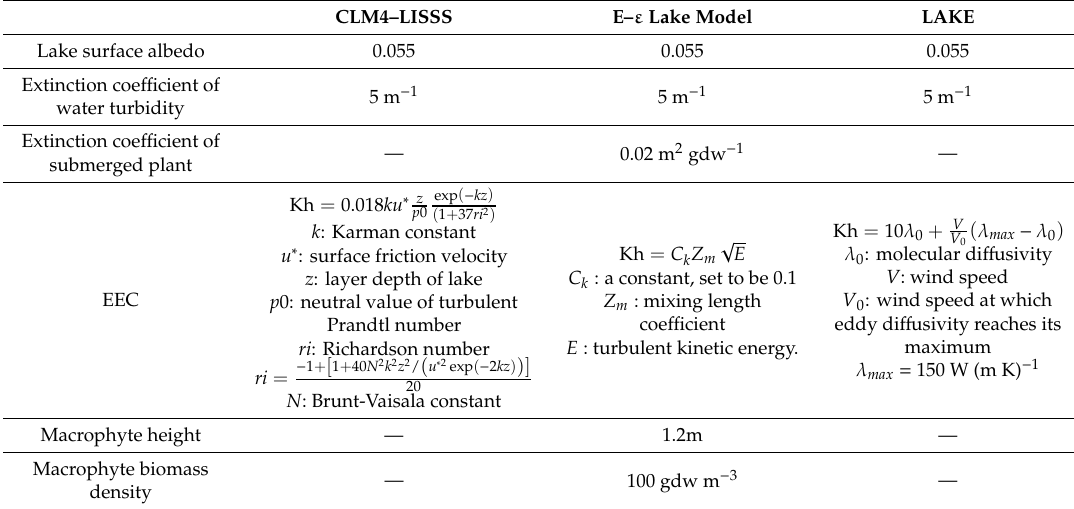
Table 2. The parameters used in the evaluation of the three models. CLM4–LISSS E– ε Lake